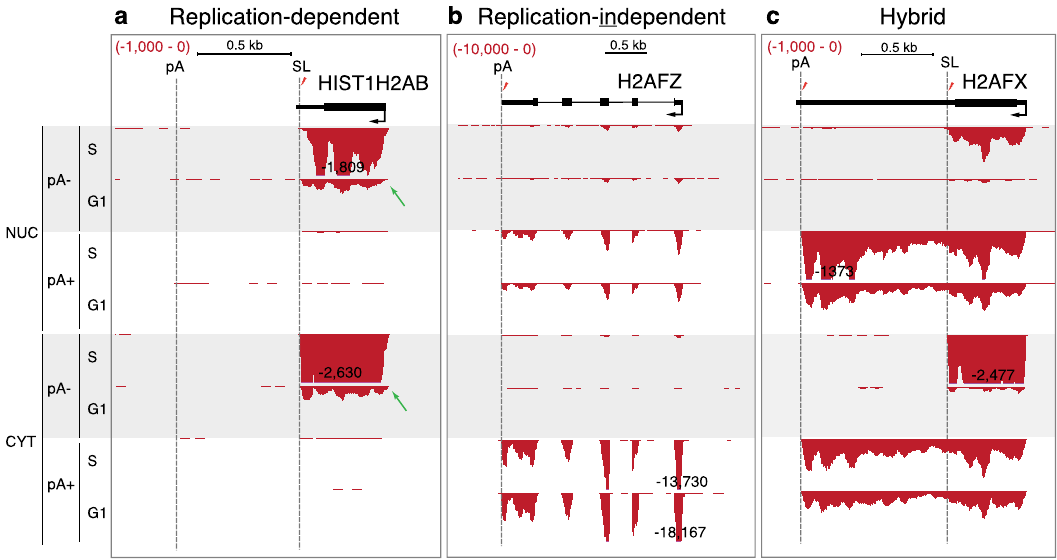
Fig. 1 H2AFX expresses poly(A) + and poly(A)- mRNA. HeLa cell RNA-seq reads aligned to human genome. Scale indicated in red in upper left corner. pA-: rRNA-depleted poly(A)- RNA. pA + : poly(A) + RNA. S and G1: S- and G1-phase-enriched cells. SL: U7-dependent cleavage site. pA: polyadenylation site. Black arrow: direction of Pol II transcription. Maximum read number indicated. Green arrows: poly(A)- histone mRNA in G1 fractions derived from 3% S-phase cell contamination (Supplementary Fig. 1b). a RNA-seq pro fi le of a typical replication-dependent histone gene. b Example of a replication- independent histone gene. c H2AFX gene with replication-dependent and independent features.